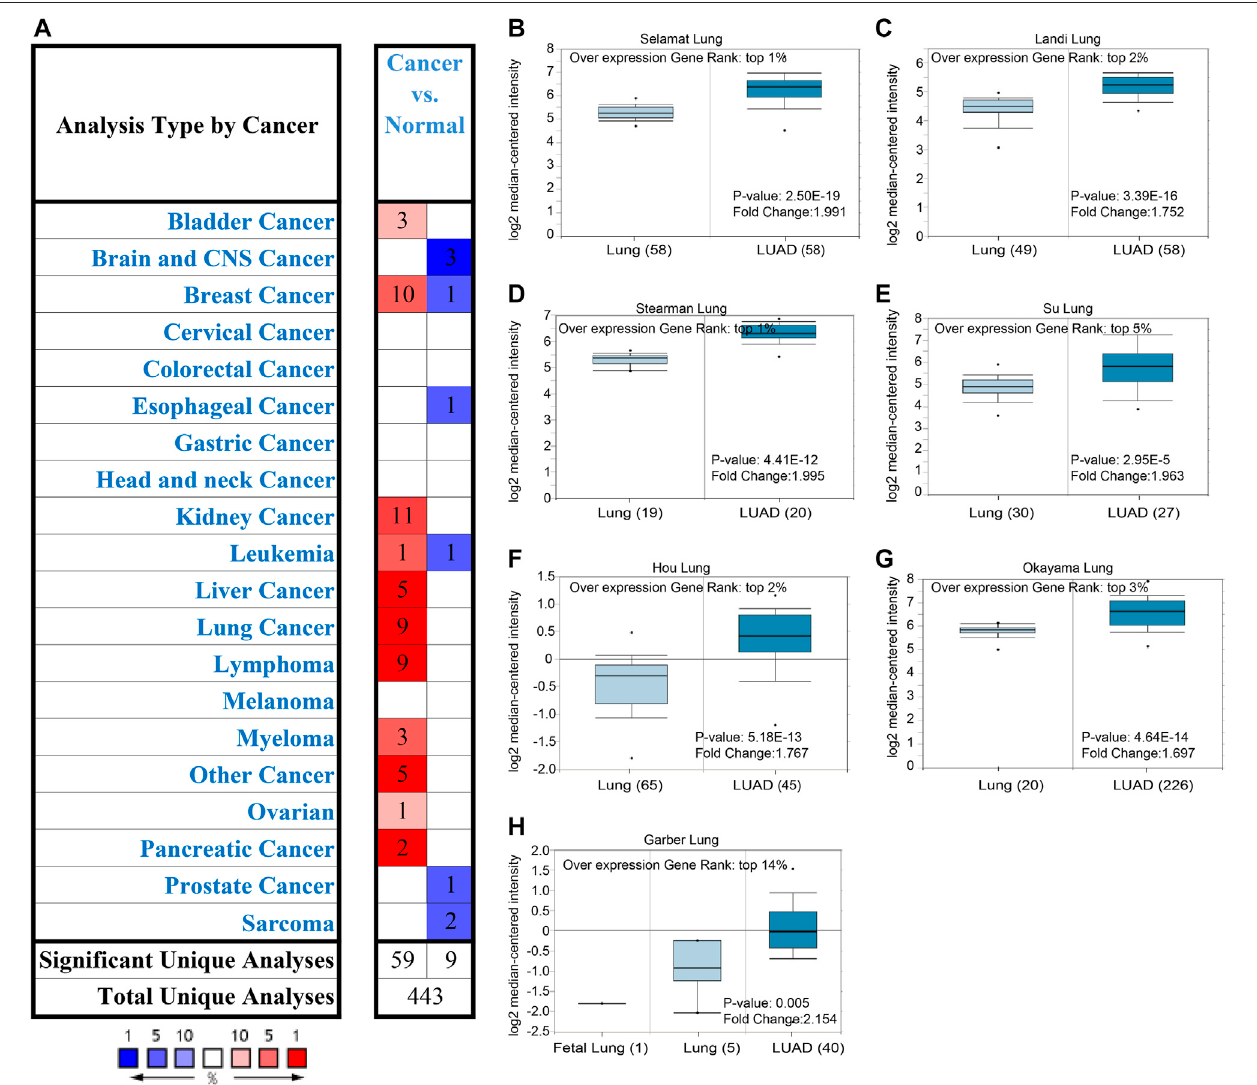
FIGURE 1 | Expression of ALDOA from Oncomine (A) ALDOA expression in different types of cancers. Red means up-regulated and blue means down-regulated (B-H) BOXplotshowingthemRNAexpressionlevelsof ALDOA inSelamatlung,Landilung,Houlung,Okayamalung,Stearmanlung,Sulung,andGarberlungdatasets,